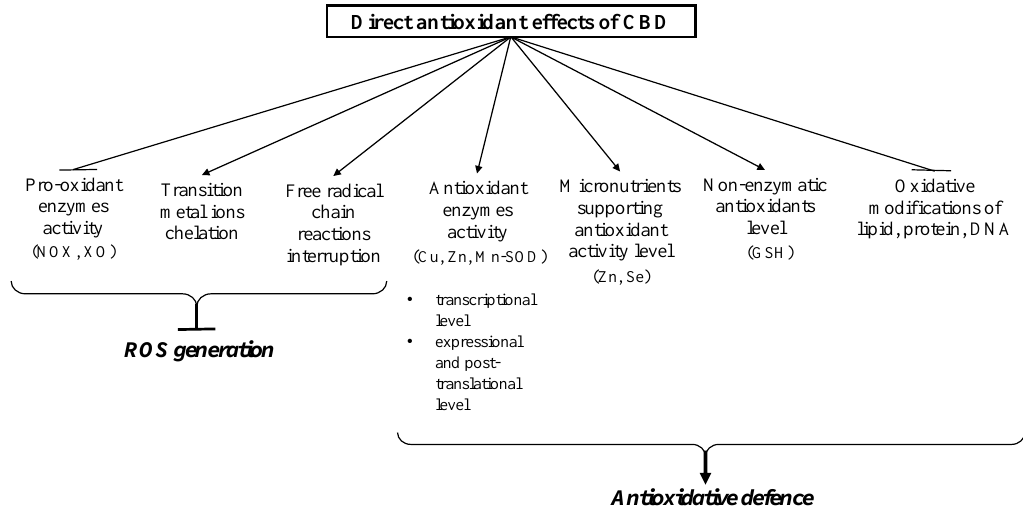
Figure 2. Direct antioxidant e ff ects of CBD (closed arrows indicate reducing e ff ects; opened arrows indicate inducing